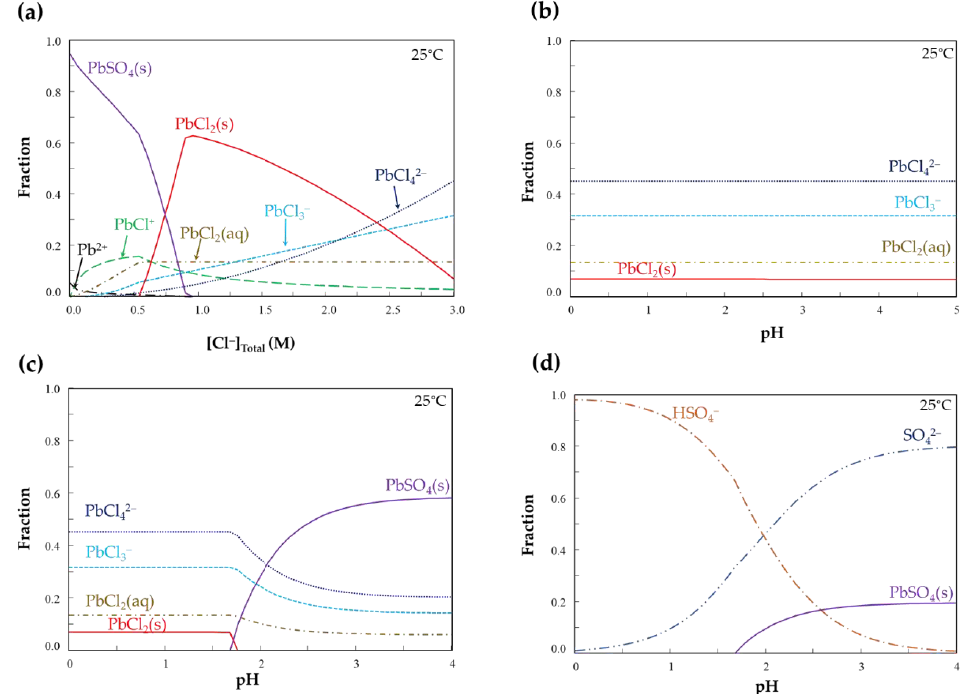
Figure 10. Thermodynamic calculation of dissolution of PbSO 4 , speciation of Pb-Cl complexes, and SO 42− at ( a ) Pb 2+ = 8 mM, SO 42− = 8 mM, pH = 1, ( b ) Pb 2+ = 8 mM, SO 42− = 8 mM, Cl − = 3 M, ( c ) Pb 2+ = 8 mM, SO 42− = 24 mM, Cl − = 3 M, and ( d ) Pb 2+ = 8 mM, SO 42− = 12 mM, Cl − = 3 M (created using the MEDUSA Ver. 1 software [33]) .